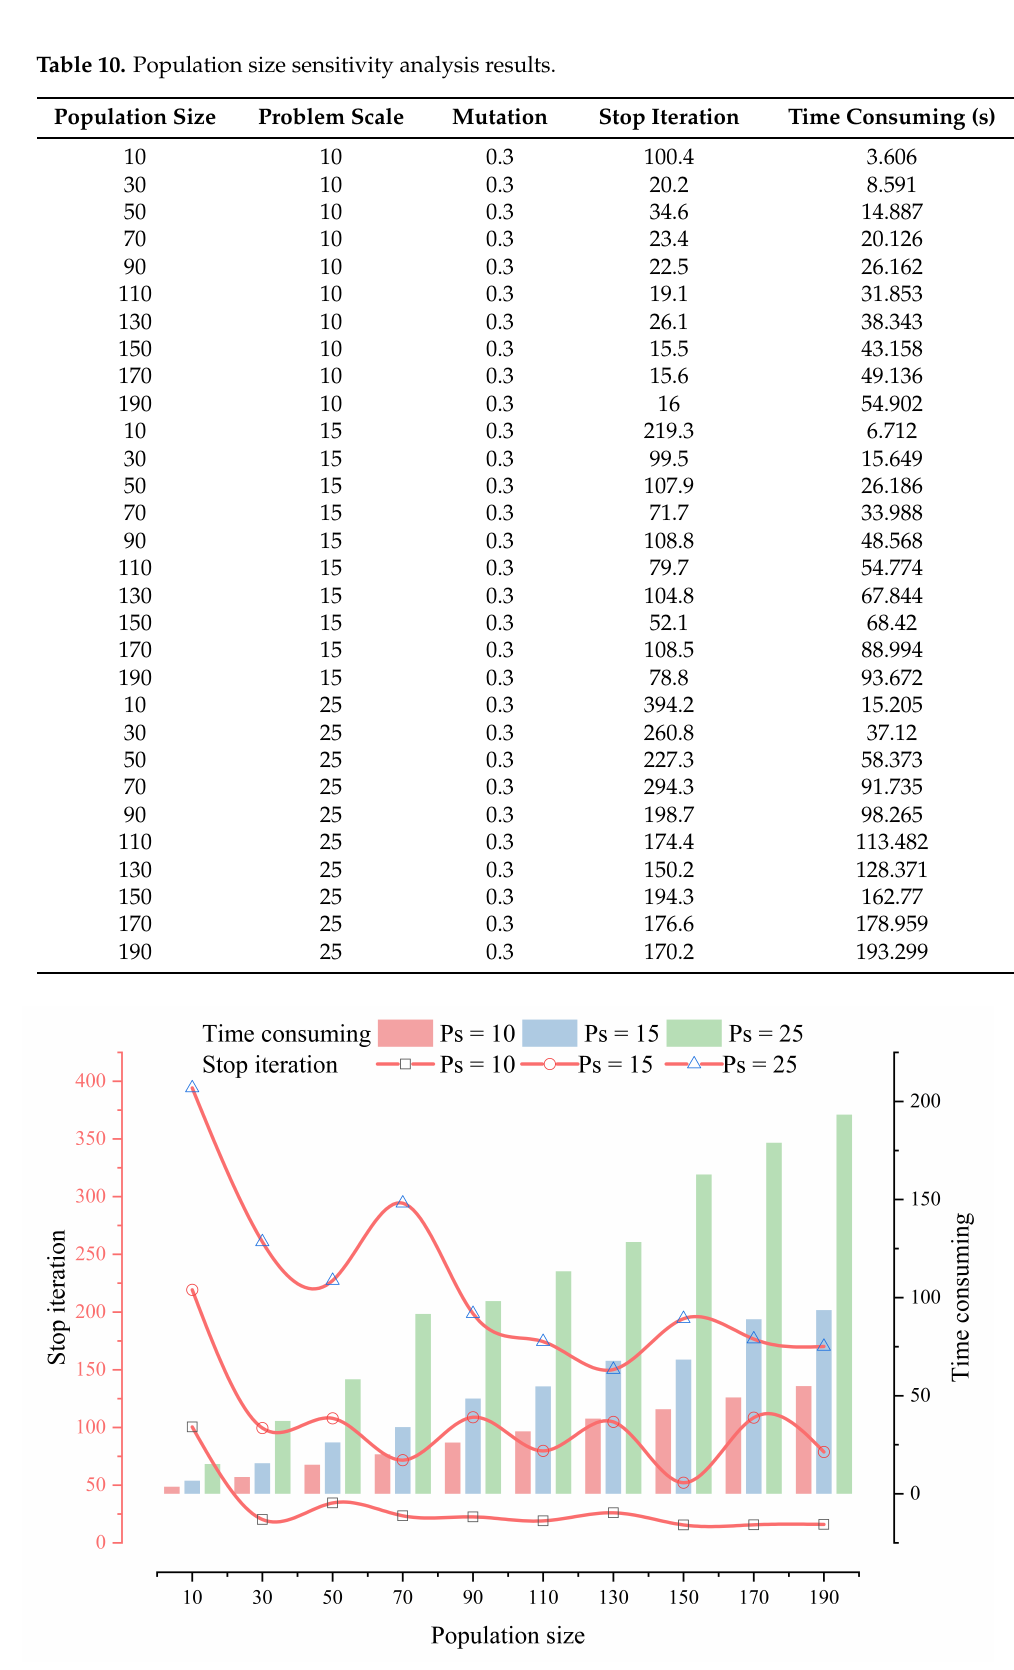
Figure 9. Performance in terms of time consuming and population size for different problem